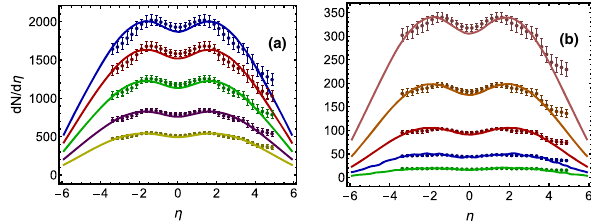
Fig. 5 The charged-particle pseudorapidity density in Pb–Pb colli- sions at 5.02 TeV obtained by aHydroQP model (solid lines) as a func- tion of pseudorapidity η . In panel a , the centrality classes correspond to 0–5, 5–10, 10–20, 20–30, and 30–40% from top to bottom and, in panel b , correspond to 40–50, 50–60, 60–70, 70–80, 80–90%, respectively, again from top to bottom. Data are from ALICE Collaboration Ref. [70]